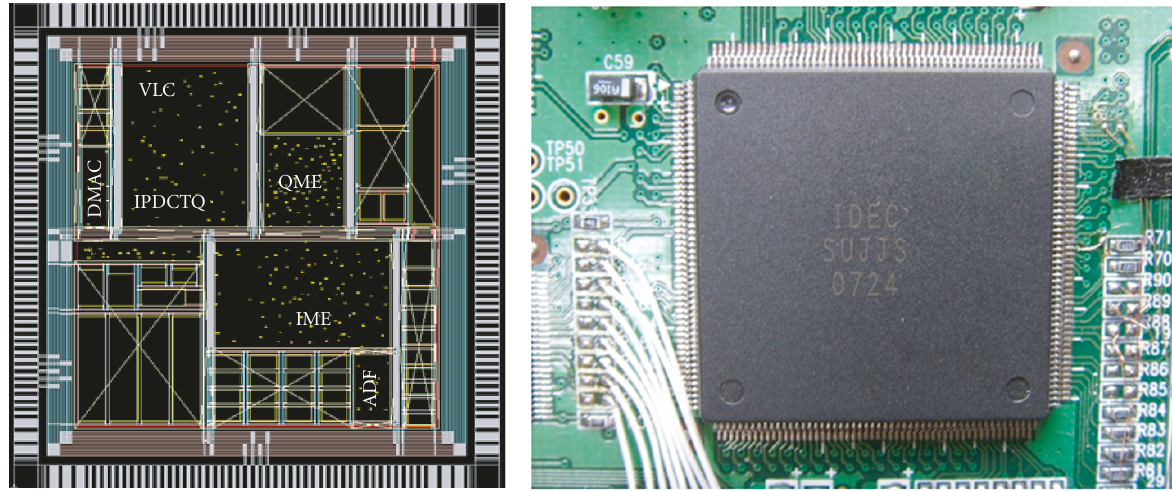
Figure 13: Chip layout and